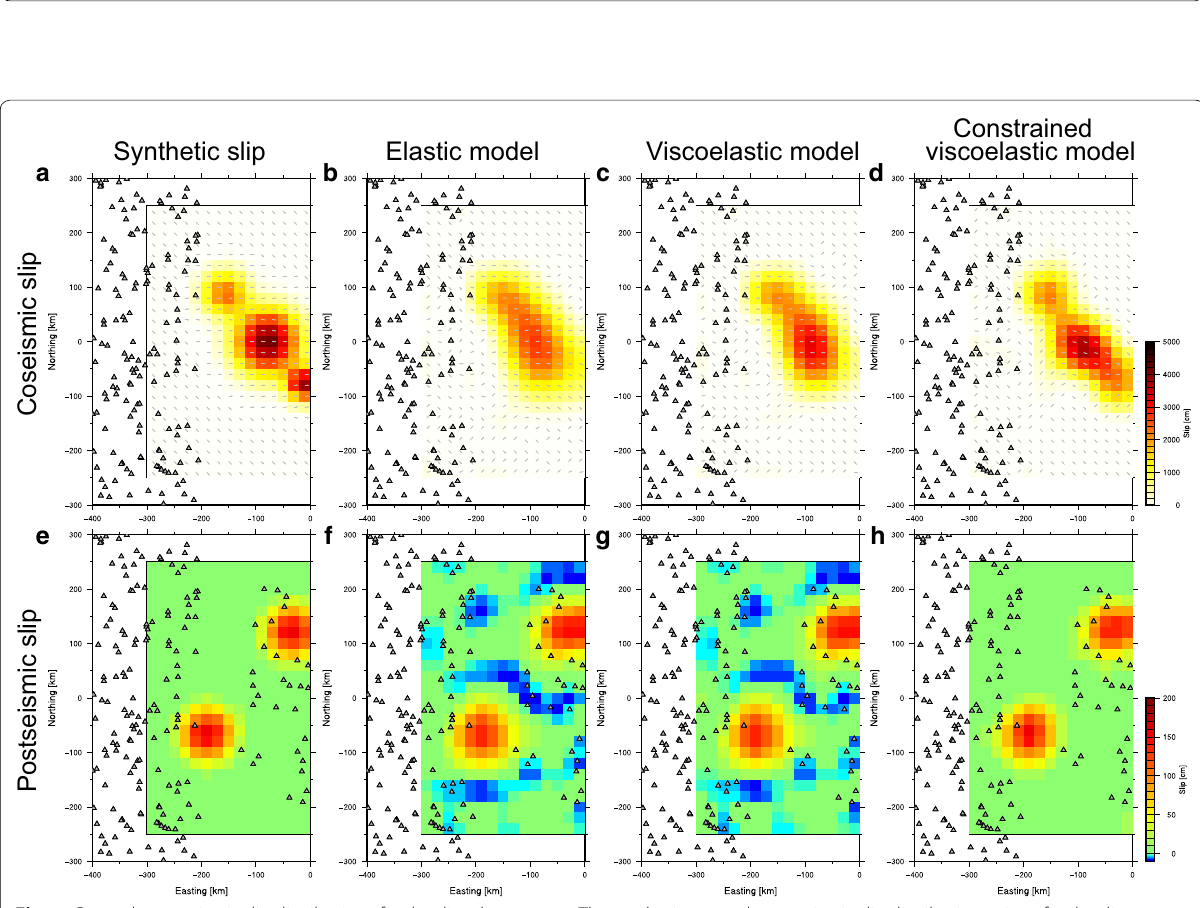
Fig. 7 Co- and post-seismic slip distributions for the dip–slip case. a , e The synthetic co- and post-seismic slip distributions given for the dip– slip case of the synthetic tests, respectively. b , f The estimated co- and post-seismic slip distributions in the elastic model, respectively. c , g The estimated co- and post-seismic slip distributions in the viscoelastic model, respectively. d , h Respectively show the co- and post-seismic slip distributions estimated in the viscoelastic model constraining negative postseismic slip. Gray triangles show the site distributions during the corresponding period. Each small gray arrow in the upper panels represents direction of coseismic slip in a sub-fault. The direction of postseismic slip is fixed to orthogonal direction to the